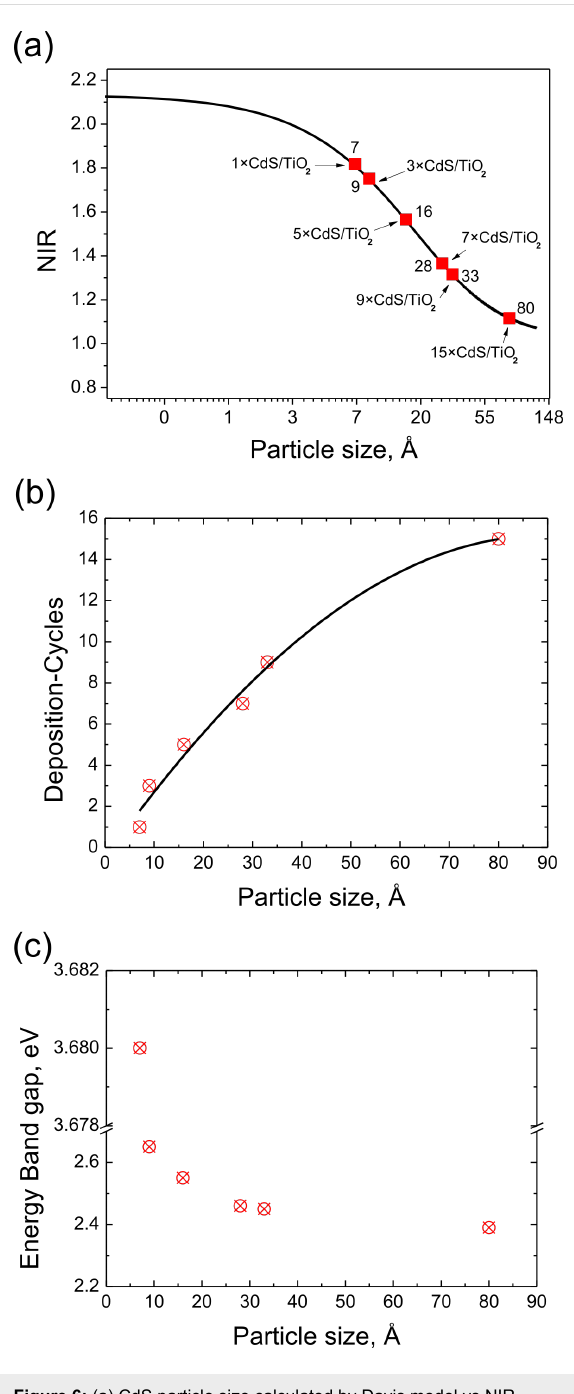
Figure 6: (a) CdS particle size calculated by Davis model vs NIR (normalized intensity ratio calculated from the intensity ratio of pure metal foil and studied material). Particle size evolution vs (b) number of deposition cycles and (c) the band gap energy.